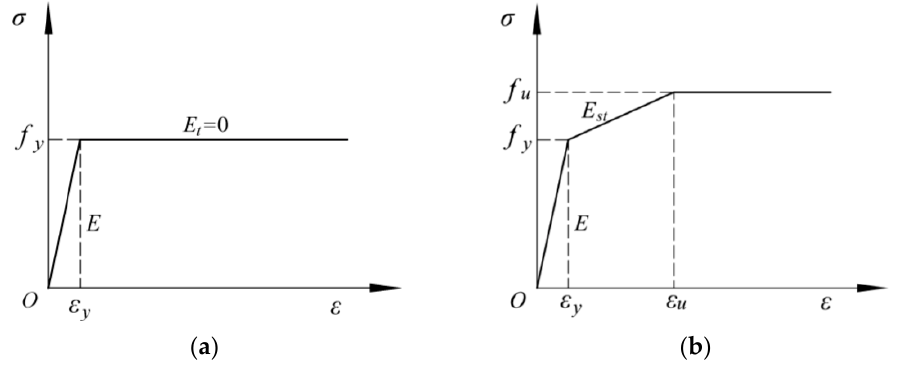
Figure 10. Constitutive model in specifications: ( a ) the perfect elastic–plastic model; ( b ) the three-stage model. E t is the tangent modulus, E st is the slope.